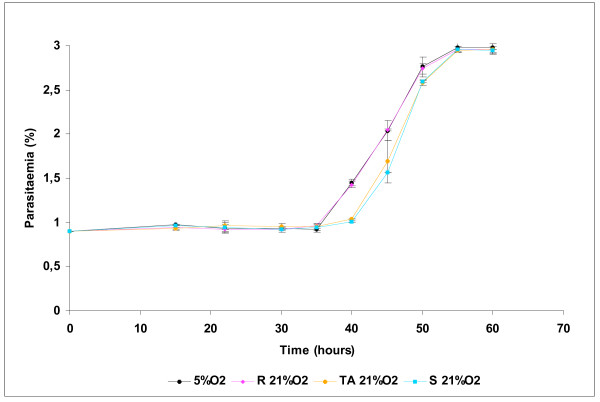
Evolution of asexual parasitaemia of synchronous cultures of Plasmodium falciparum exposed to 21% O2 during ten hours at ring, trophozoïte or schizont stage. Each point represents the mean ± standard deviation of three experiments.